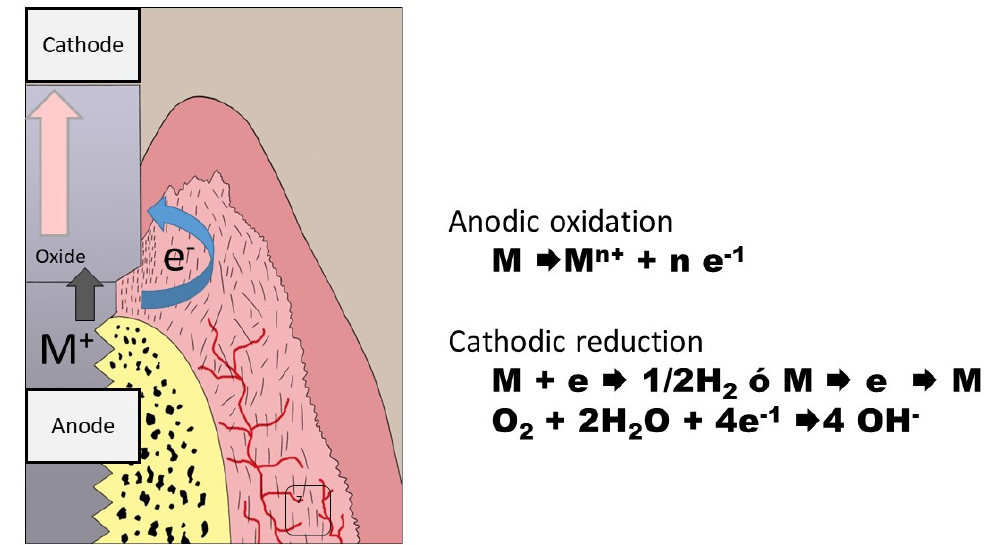
Figure 1. The anode, the metal that is oxidized (M), releases ions (M n+ ) to the medium and an equal number of electrons (n) as the valence of these ions (M n+ ). The metal that is reduced can incorporate these electrons (e) both on its surface and in its metal lattice by reacting with both hydrogen and oxygen, depending on the medium.